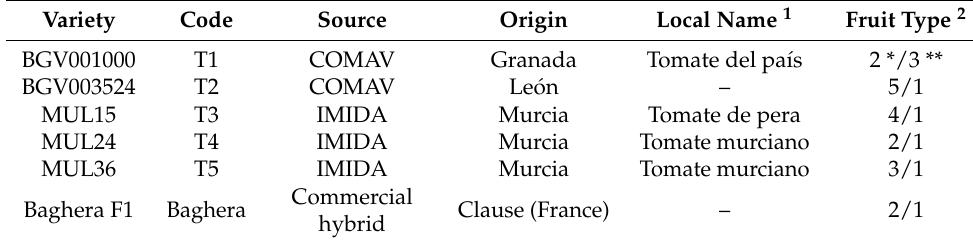
Table 1. Sources, origins and fruit type of the studied